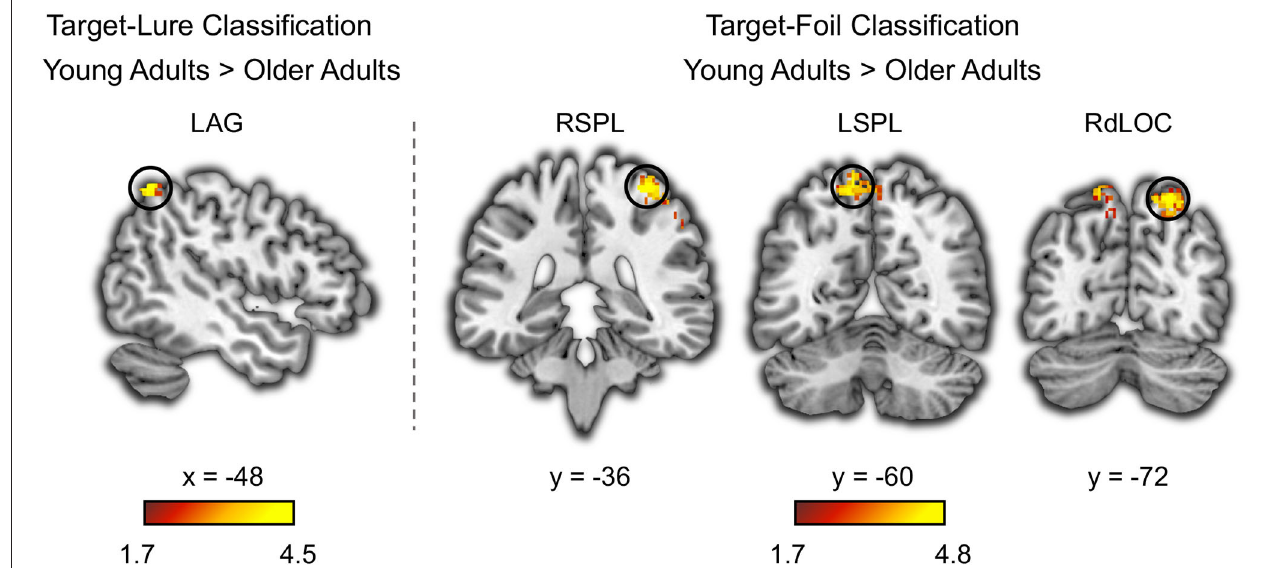
FIGURE 3 | Age deficits in neural discriminability based on whole-brain searchlight classification analysis. The left angular gyrus (LAG) showed age deficits in the neural pattern classifications accuracy for distinguishing between targets and lures. The right superior parietal lobe (RSPL), the left superior parietal lobe (LSPL), and the right dorsolateral occipital cortex (RdLOC) showed age deficits in the neural pattern classifications accuracy for distinguishing between targets and foils. Neural discriminability in these brain regions was at above-chance level in young adults, and it was higher in young adults compared to older